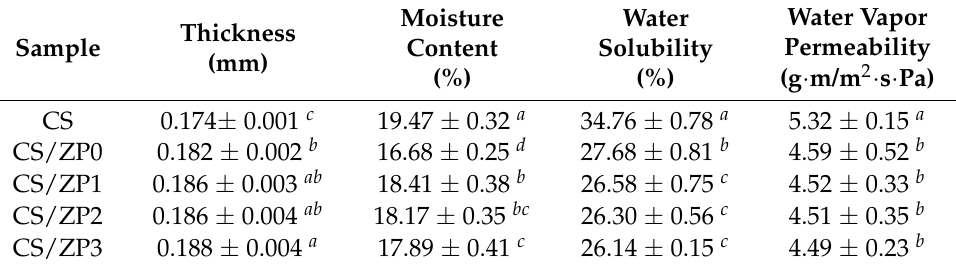
Table 2. Functional properties of bionanocomposite